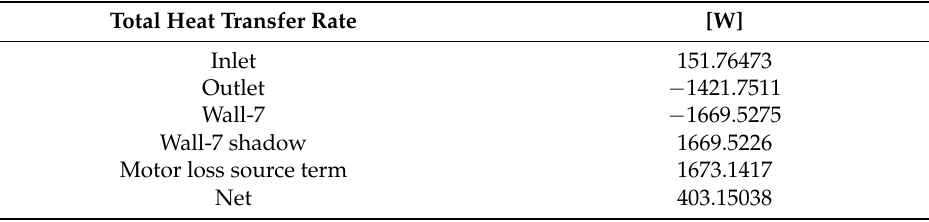
Table 2. Overall motor losses from Helical water jacket.